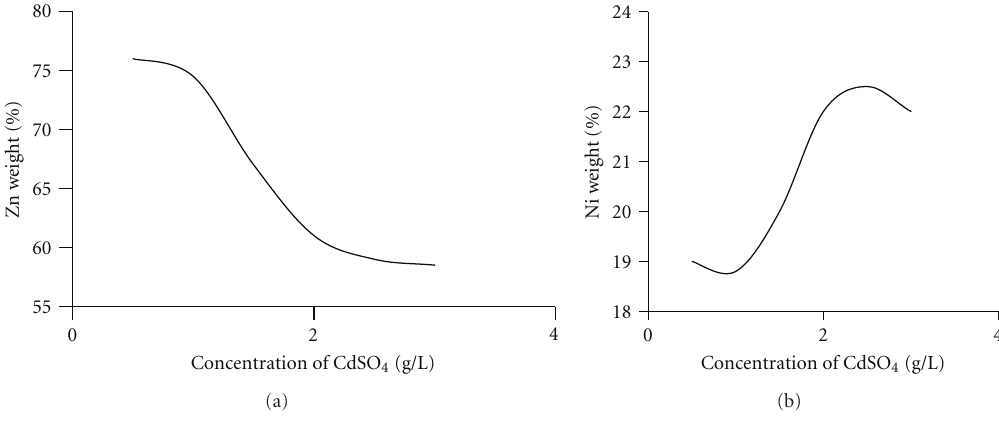
Figure 7: E ff ect of cadmium concentration on (a) Zn and (b) Ni at 4mA/cm 2